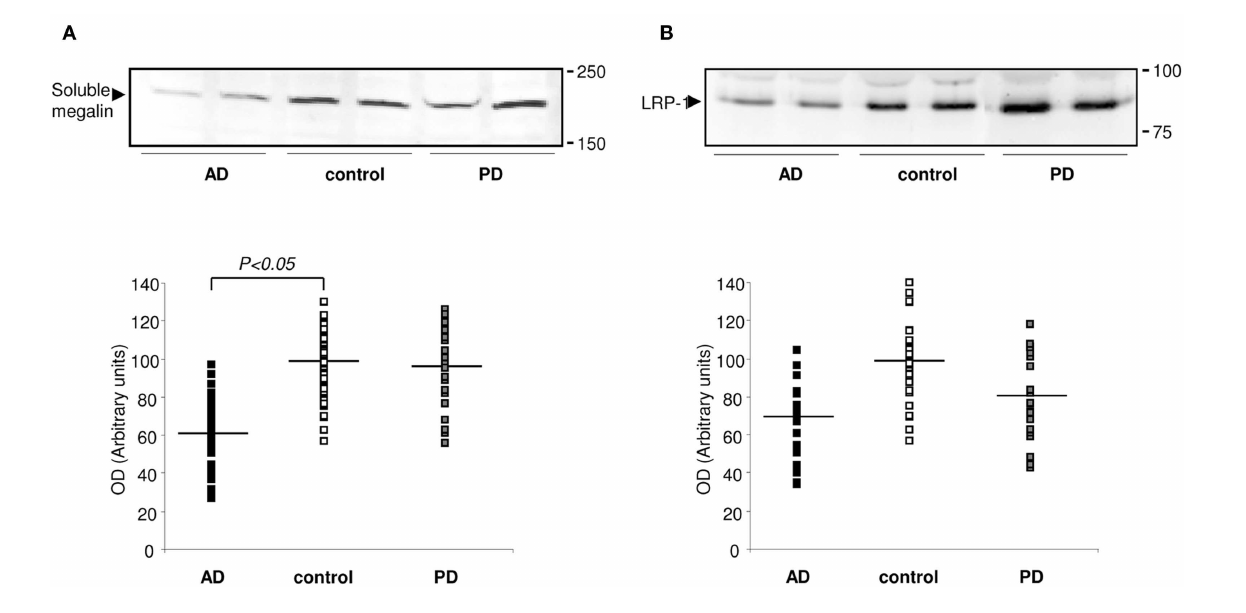
FIGURE 2 | Expression of megalin and LRP-1 in human CSF . (A) Soluble megalin (A) , and LRP (B) expression measured onWestern blots in CSF samples from non-demented subjects (controls; white), with Alzheimer’s